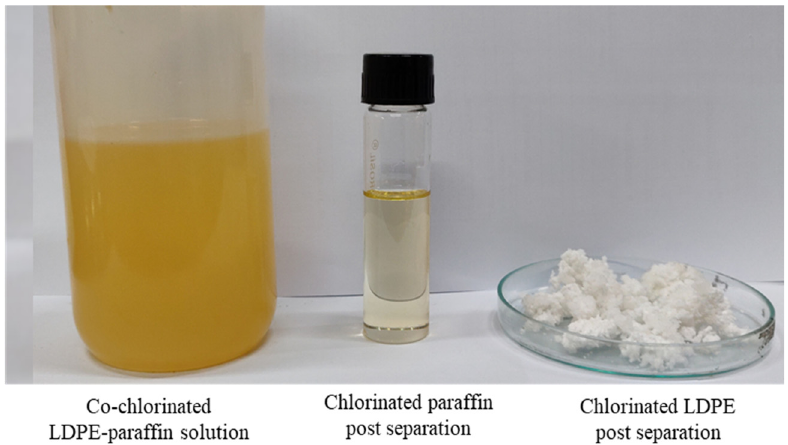
Figure 10: Photograph of co - chlorinated LDPE - para ffi n solution, chlorinated para ffi n and chlorinated LDPE post separation using methanol (